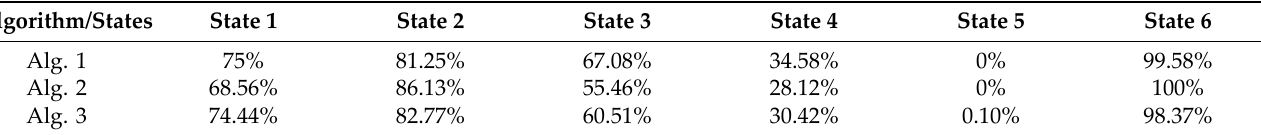
Table 4. Group Concentration percentage per time slot.